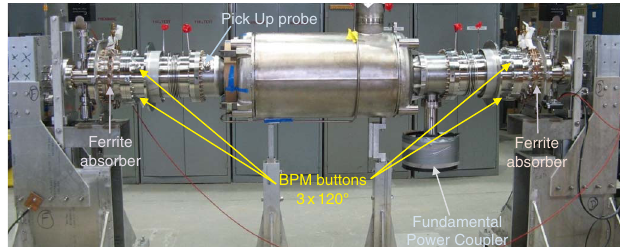
FIG. 1. View of ECX five-cell cavity vacuum string assembly with ferrite dampers, but without its cryostat. HOM signals are obtained from a pickup (PU) probe, beam position monitor (BPM) buttons, and the fundamental power coupler